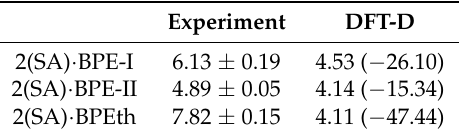
Table 10. Experimentally determined (cid:101) of co-crystals compared to the isotropically averaged (cid:101) computed using DFT-D. Percent deviation from experiment is in